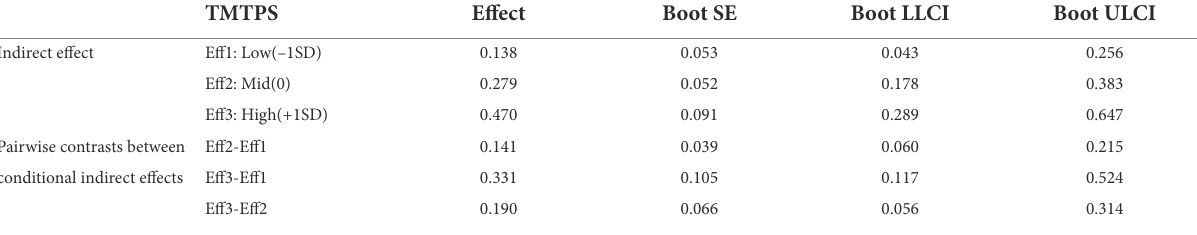
TABLE 7 Moderated mediating effect test